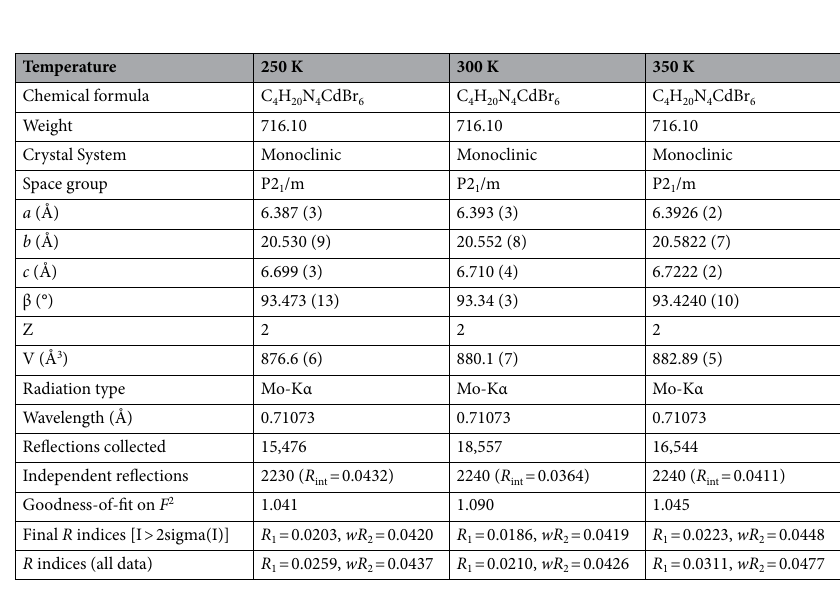
Table 1. Crystal data and structure refinement for [NH 3 (CH 2 ) 2 NH 3 ] 2 CdBr 4 ∙2Br at 250 K, 300 K, and 350 K.